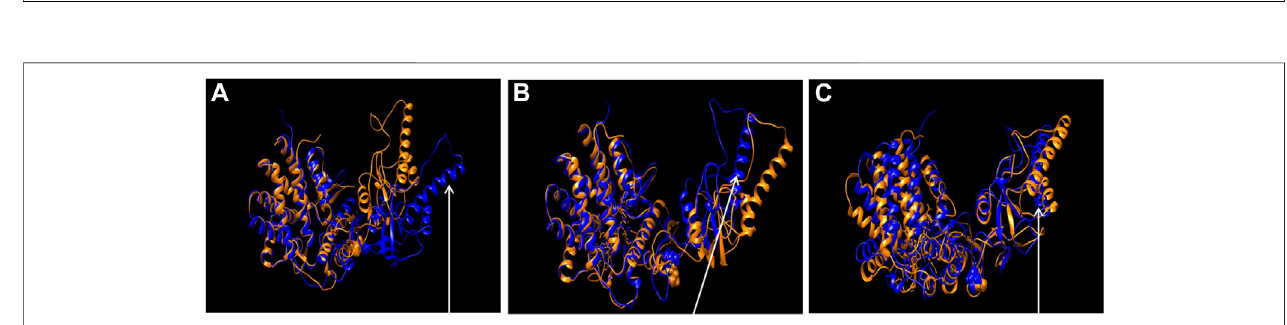
FIGURE 10 | Comparison of wild type and the mutant CCT5 using molecular models. Superposition of the most probable conformations obtained by molecular dynamics simulations of wild type CCT5 (orange) and the mutant Leu224Val CCT5 (blue), nucleotide free (A) , ATP-bound (B) , and ADP-bound (C) . Spheres in the intermediate domain correspond to Leucine (orange, wild type) and Valine (blue, mutation) at position 224. Noteworthy in panel (A) is the greater opening of the mutant protein,especially atthe levelofthe α 9helix,comparedtothewild-type protein (arrow). Inpanel (B) ,the α 9helix ofthemutant CCT5ismore closed thanin thewild type (arrow),incontrastwith thesituation inthe nucleotide-free conditions, shown in panel (A) .In panel (C) , under theADP-bound conditions, themutant protein shows the lid still more closed that in the wild type (arrow).